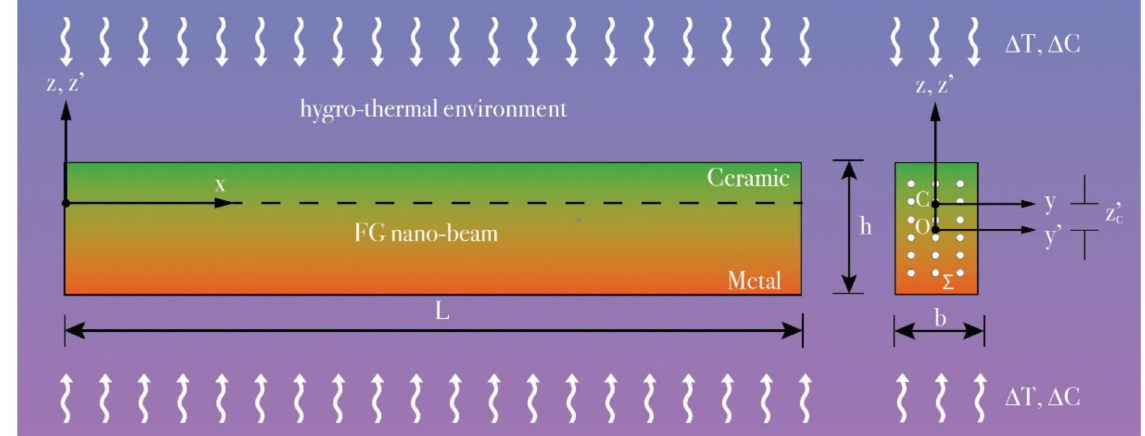
Figure 1. Coordinate system and configuration of a porous FG Bernoulli–Euler nano-beam.